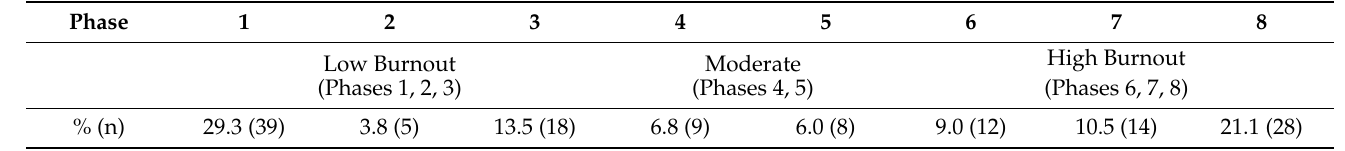
Table 3. Classification of the participants according to the phase model of Golembiewski et al (1986)